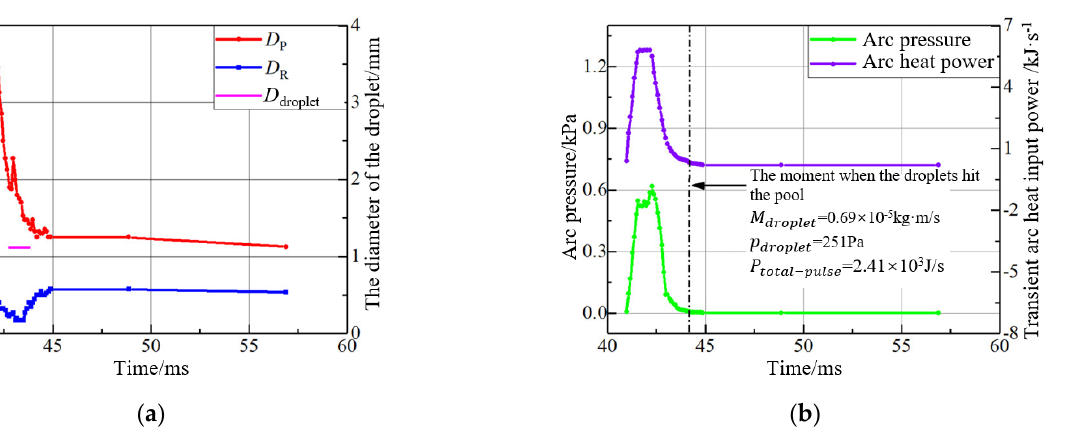
Figure 8. ( a ) The droplet and arc size at different times during a single pulse period ( I p = 485 A); ( b ) transient arc pressure and heat input power ( I p = 485 A).